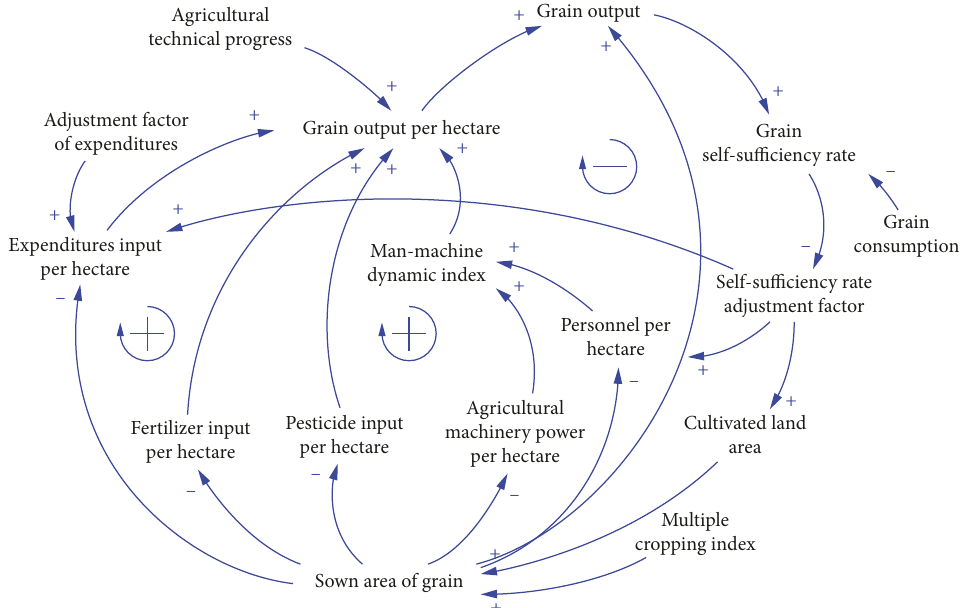
Figure 1: Feedback loop diagram between main variables of the